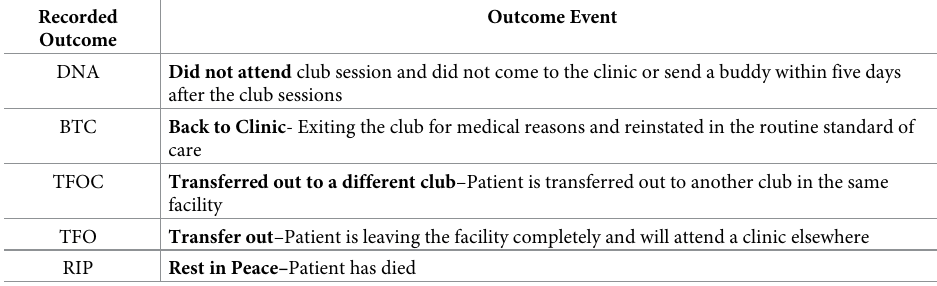
Table 1. Codes for the recording of retention in care outcomes in the club register.